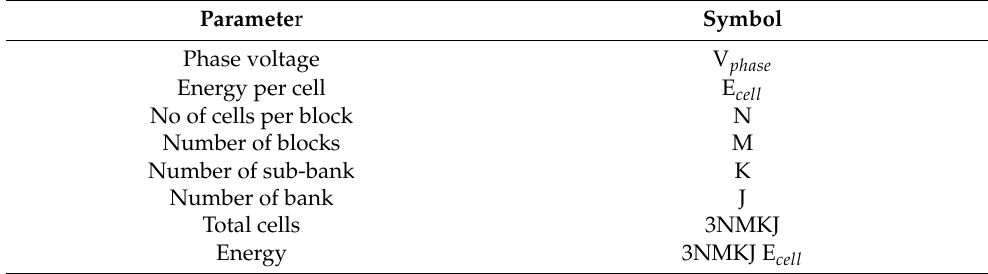
Table 1. Proposed three-phase BESS